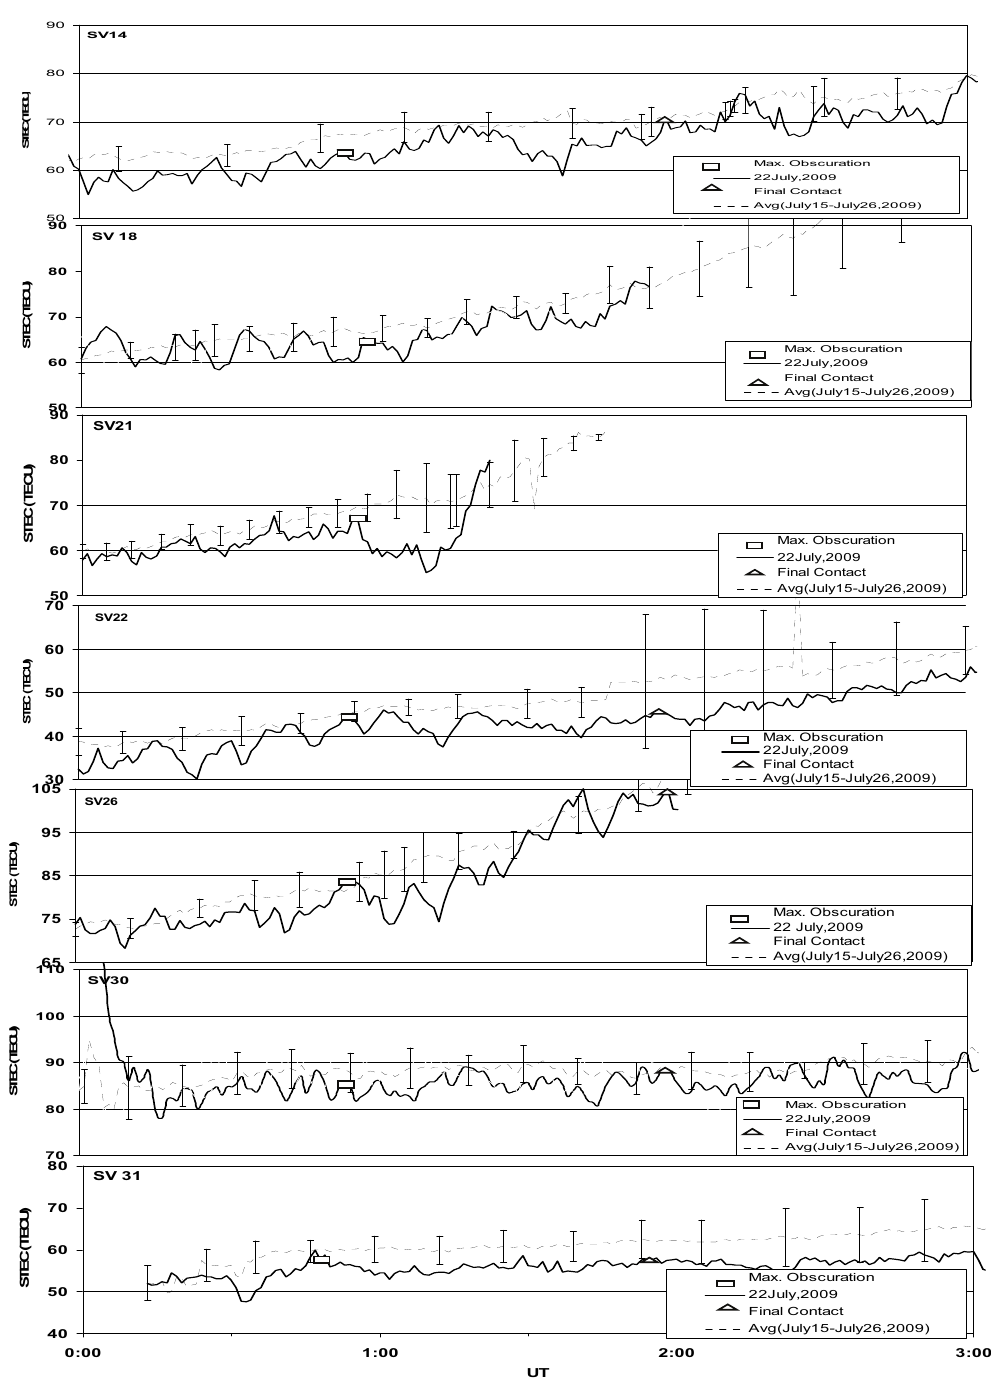
Fig. 5. The 12 days average STEC (15–26 July 2009) is shown by dotted line. The black solid line represents TEC of 22 July 2009. The vertical lines are the standard deviation of STEC ( ± 1 σ) of these